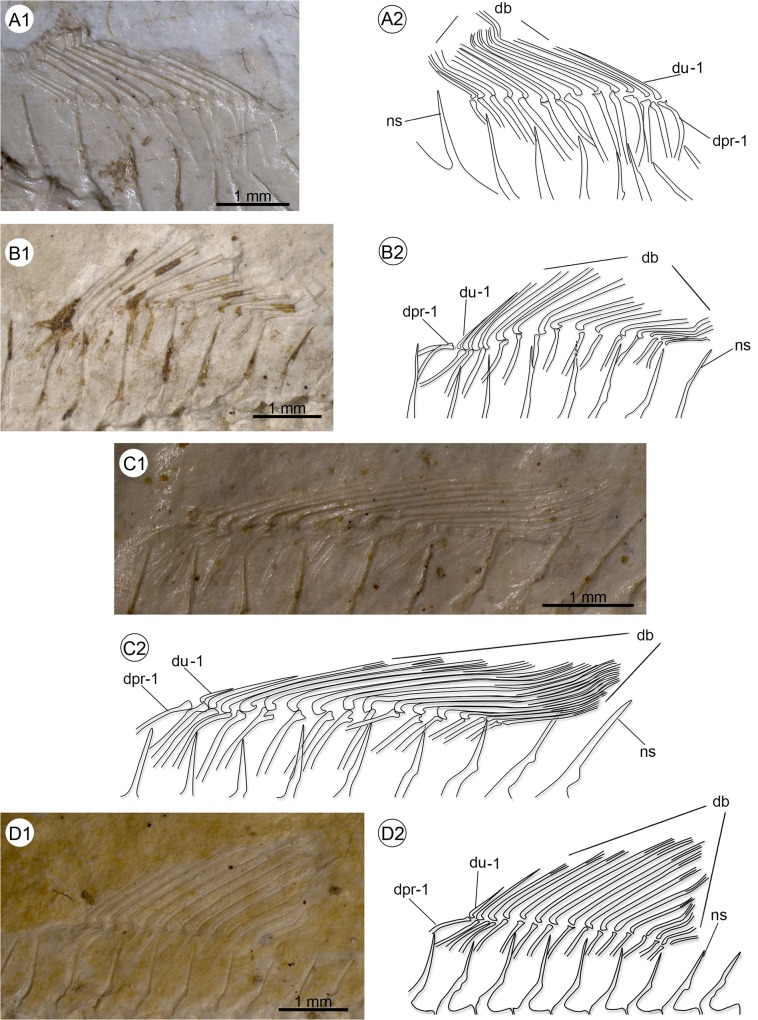
Polymorphism in the arrangement of the proximal radials of the dorsal fin seen in †Kenyaichthys nov. gen.
A1–A2 †Kenyaichthys kipkechi sp. nov. (paratype 1154a´04): dorsal fin with a single short ray and 12 long rays; a single proximal radial supports the first short ray, two proximal radials support the first long ray, and one proximal radial supports all remaining rays, right lateral view; B1–B2 †K. kipkechi sp. nov. (paratype 1152´04): dorsal fin with two short rays and 11 long rays; two proximal radials support the first short ray and one proximal radial supports all other rays with the exception of the last ray, left lateral view; C1–C2 †K. kipkechi sp. nov. (paratype 1206(1)´04): dorsal fin with two short rays and 13 long rays; two proximal radials support the second short ray and one proximal radial supports all other rays, left lateral view; D1–D2 †K. kipkechi sp. nov. (paratype 1168´04): dorsal fin with two short rays and 14 long rays; two proximal radials support the first long ray and one proximal radial supports all other rays with the exception of the last ray, left lateral view. Abbreviations: db, branched rays of dorsal fin; dpr-1, first dorsal proximal radial; du-1, first unbranched dorsal fin ray; ns, neural spine.